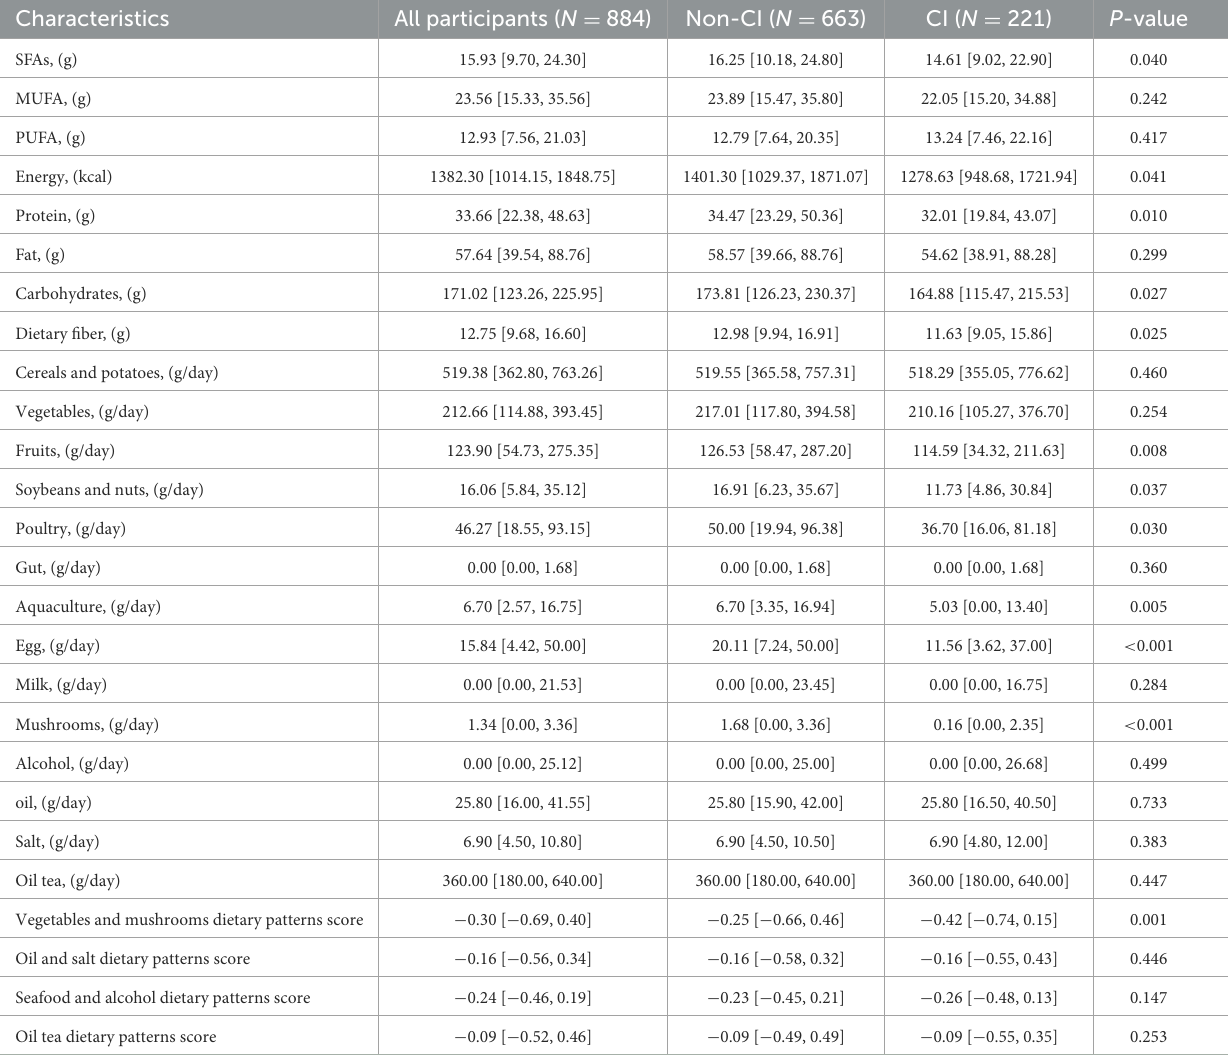
TABLE 3 Nutrients and factor scores of participants with cognitive impairment and normal group.